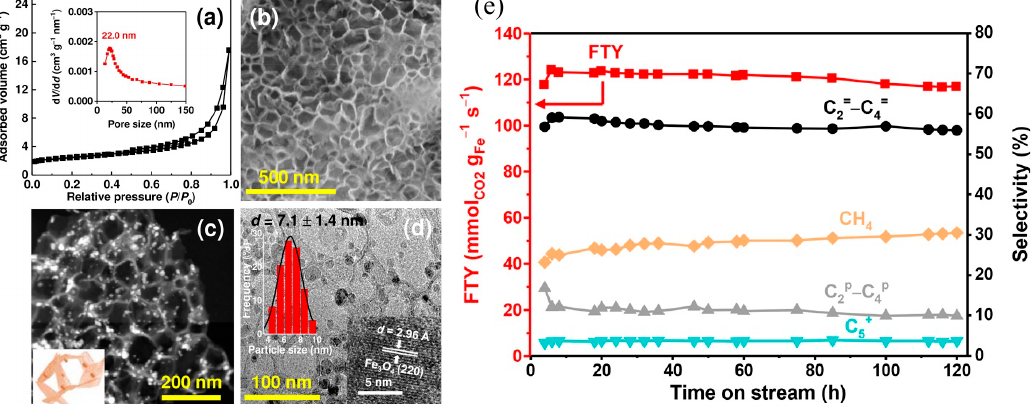
Figure 25. ( a ) N 2 physisorption isotherms, ( b ) SEM image, ( c ) HAADF − STEM image, and ( d ) TEM image and particle distribution of the FeK1.5/HSG catalyst. ( e ) CO 2 hydrogenation over the catalyst FeK1.5/HSG during a TOS of 120 h (testing conditions: mass of catalyst = 0.15 g, T = 613 K, P = 20 bar, H 2 /CO 2 molar ratio = 3, and GHSV = 26 L h − 1 g − 1 ). Adapted with permission from ref. [127]. Copyright 2018 American Chemical Society.